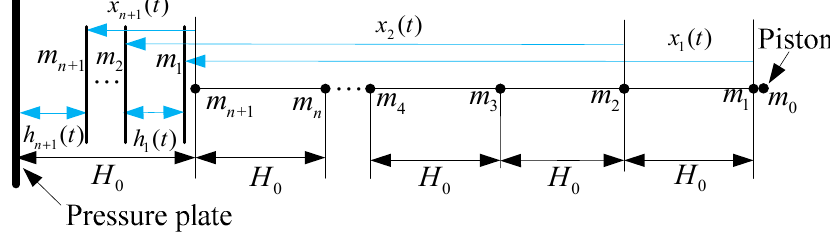
Figure 5. Variation of oil film thickness between N pairs of friction pairs and pressure plates